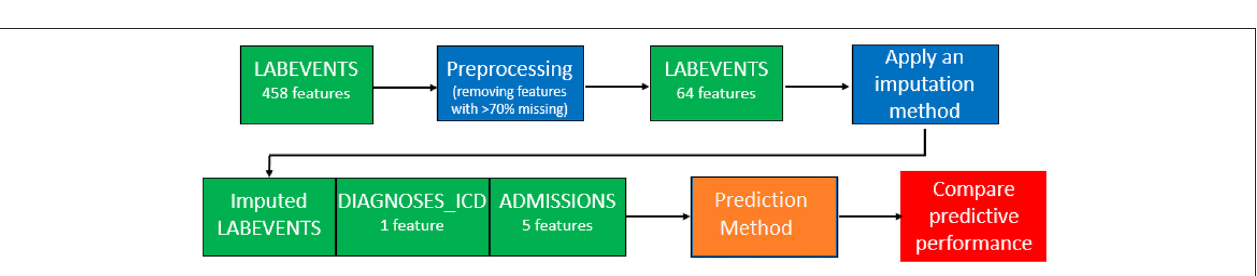
FIGURE 2 | Our pipeline of the MIMIC-III data imputation and